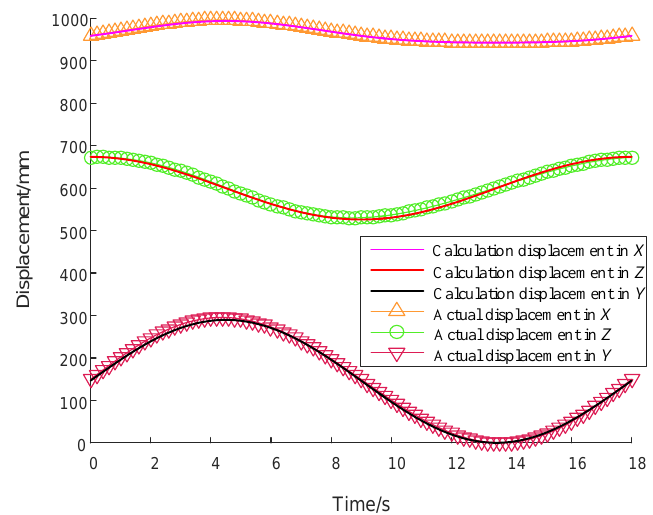
Figure 16. Comparisons of displacements between the theoretical and the experiment.